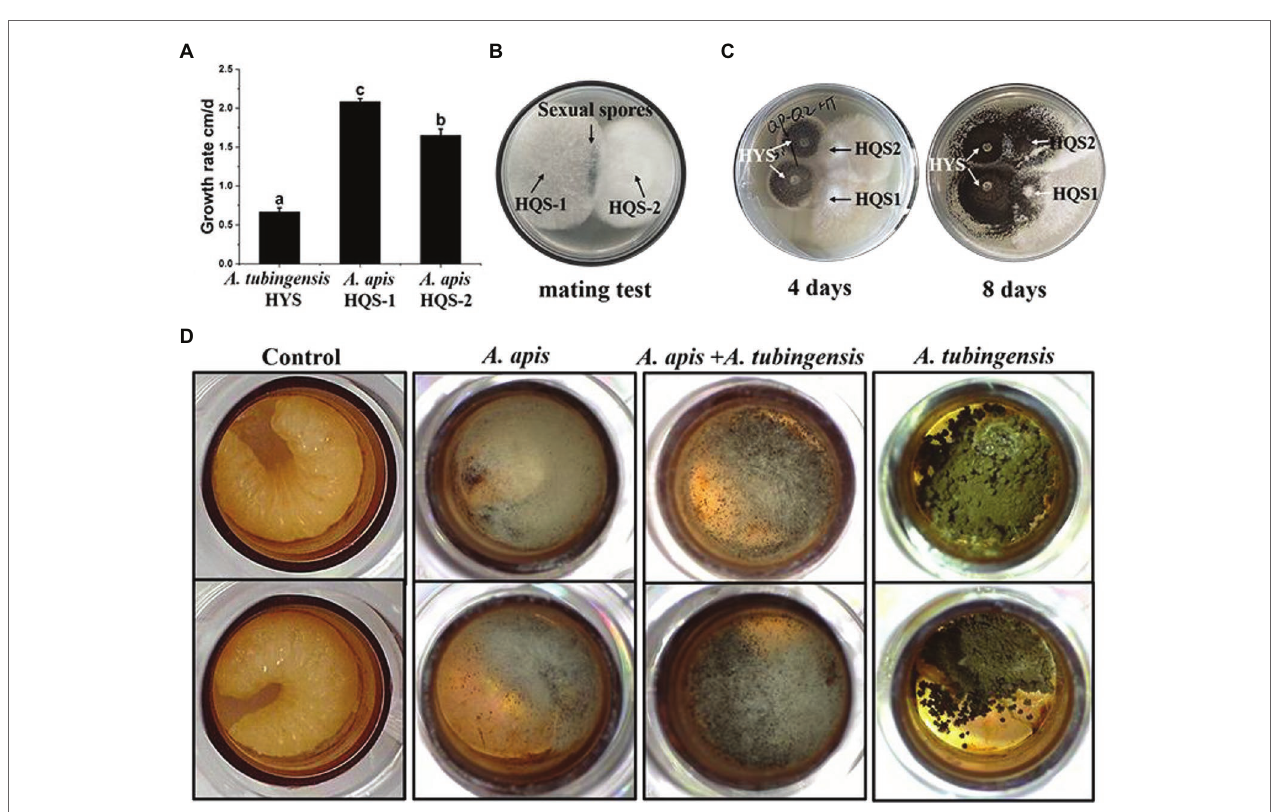
FIGURE 4 | Growth rate and pathogenicity test of Aspergillus apis and Aspergillus tubingensis . Growth rate of A. apis and A. tubingensis (A) . Mating test between A. apis HQS-1 and HQS-2 (B) . Co-cultivation of A. apis and A. tubingensis on PDA plate at different culture time (C) . Aspergillus apis and A. tubingensis inoculated honey bee larvae alone or together (D)